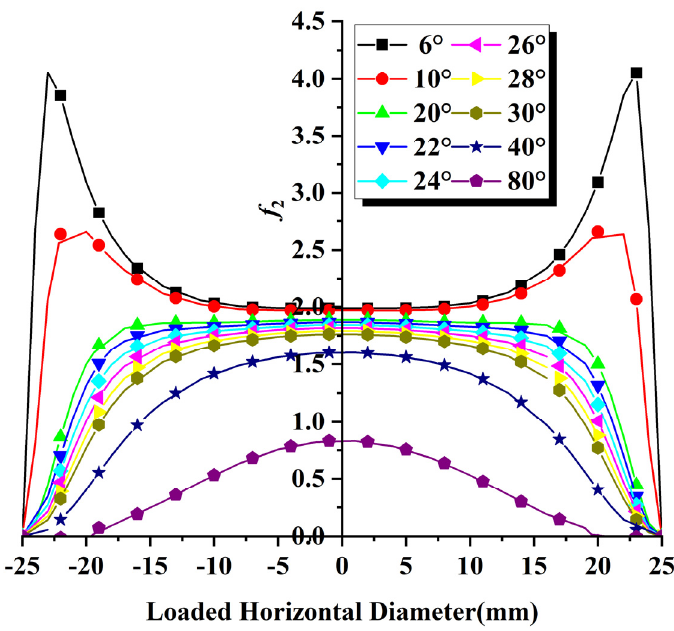
Figure 9. Non-dimensional Griffith equivalent stresses along loaded